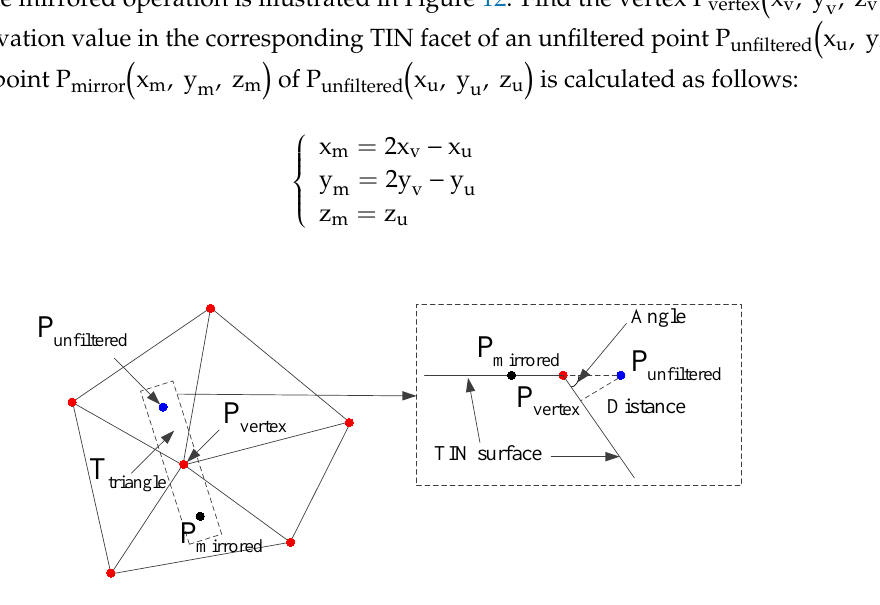
Figure 12. Mirrored operation.